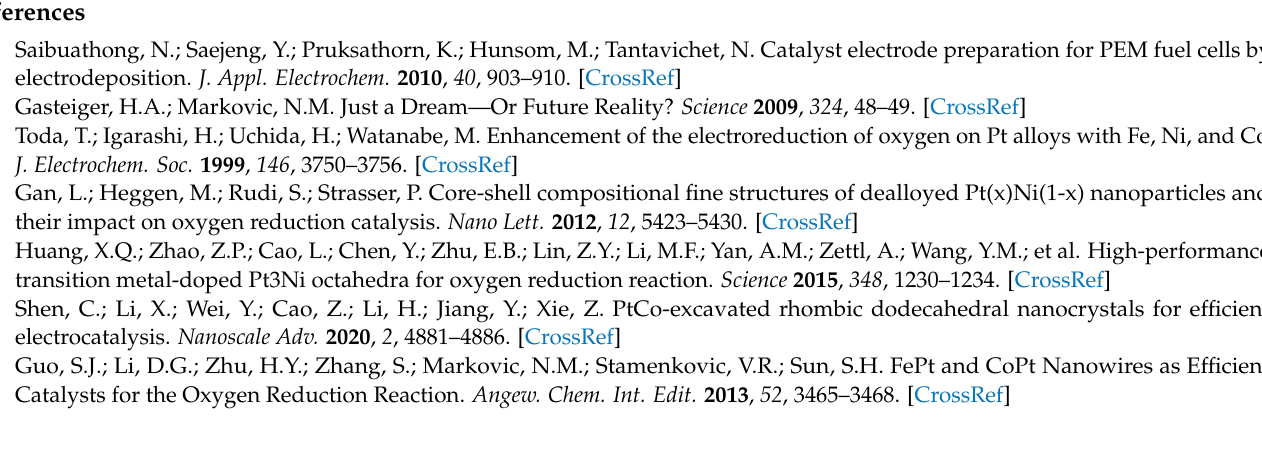
Pt/C; Figure S3: CV and LSV curves of Pt 3 Co nanoparticles and Pt/C before and after 5000 cycles ADT; Figure S4: TEM image of Pt/C, Pt 3 Co nanoparticles and Pt 3 Co superlattice before and after ADT; Figure S5: theoretical model of Pt (111) and Pt 3 Co (111); Figure S6: Tafel plot of Pt/C, Pt 3 Co Table S1: detail electrochemical data of all the catalyst in this paper; Table S2: Performance of catalyst in this work and several representative results with high performance from recent published work